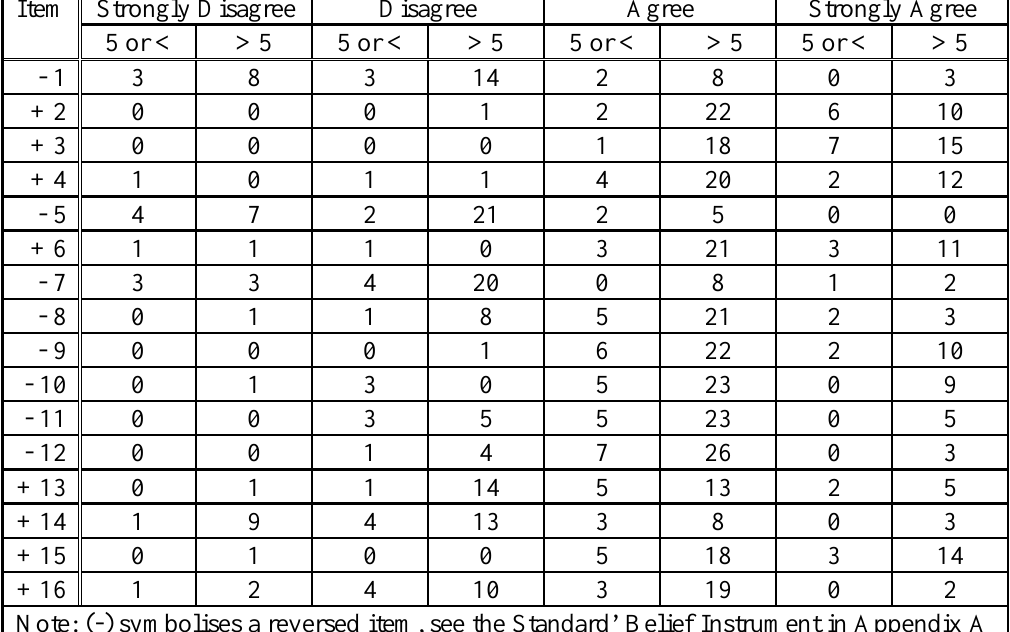
Table 2: Frequency count by years of teaching per item on the SBI